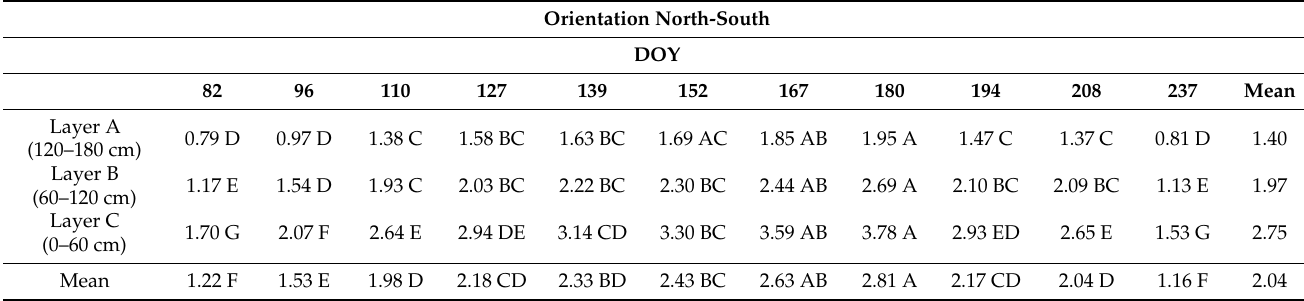
Table 4. LAI (m 2 m − 2 ) seasonal pattern recorded in different layers (layer A 120–180 cm, layer B 60–120 cm, layer C 0–60 cm) for two row orientations. The letter denotes statistical differences between DOYs for each layer (SNK test). Lower case letters denote statistical differences with p = 0.05. Capital letters denote statistical differences with p =